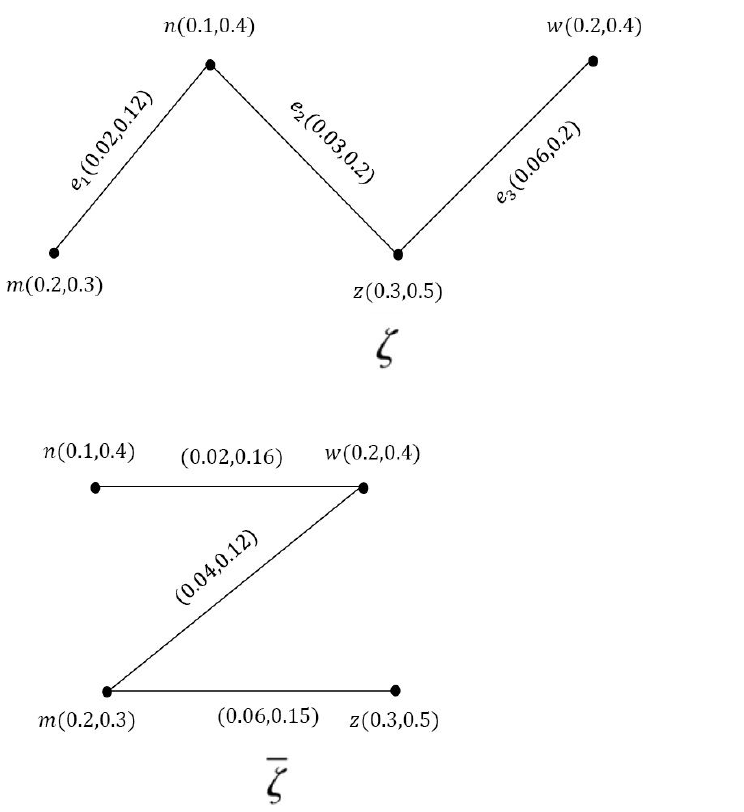
Figure 12. Product vague graphs ζ and ζ